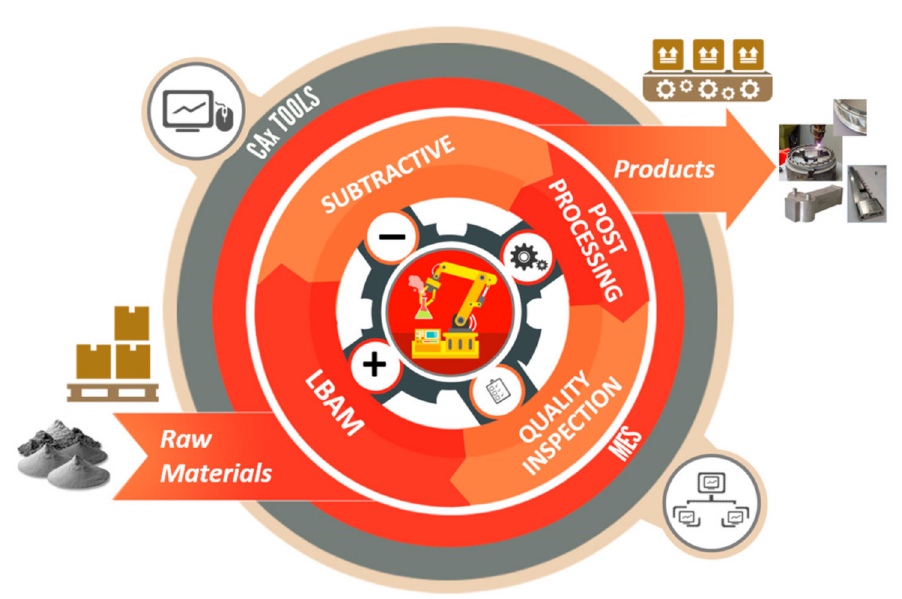
Figure 1. Conceptual overview of